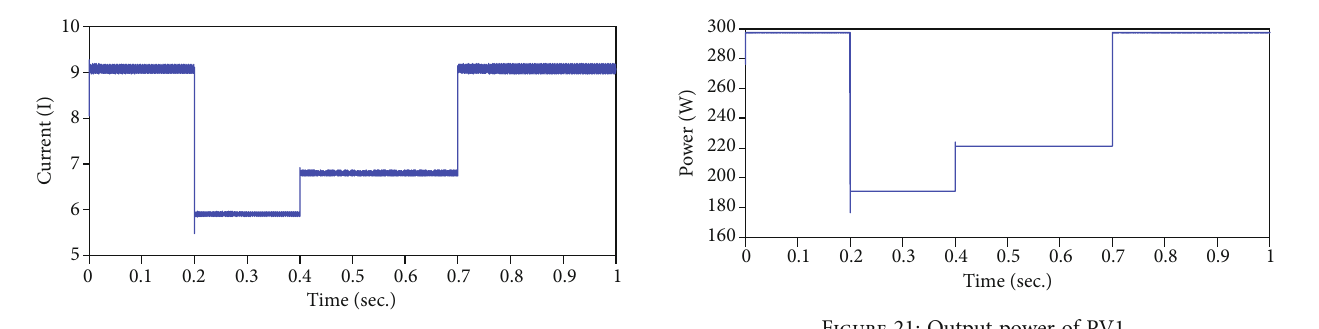
Figure 20: Current of PV1.